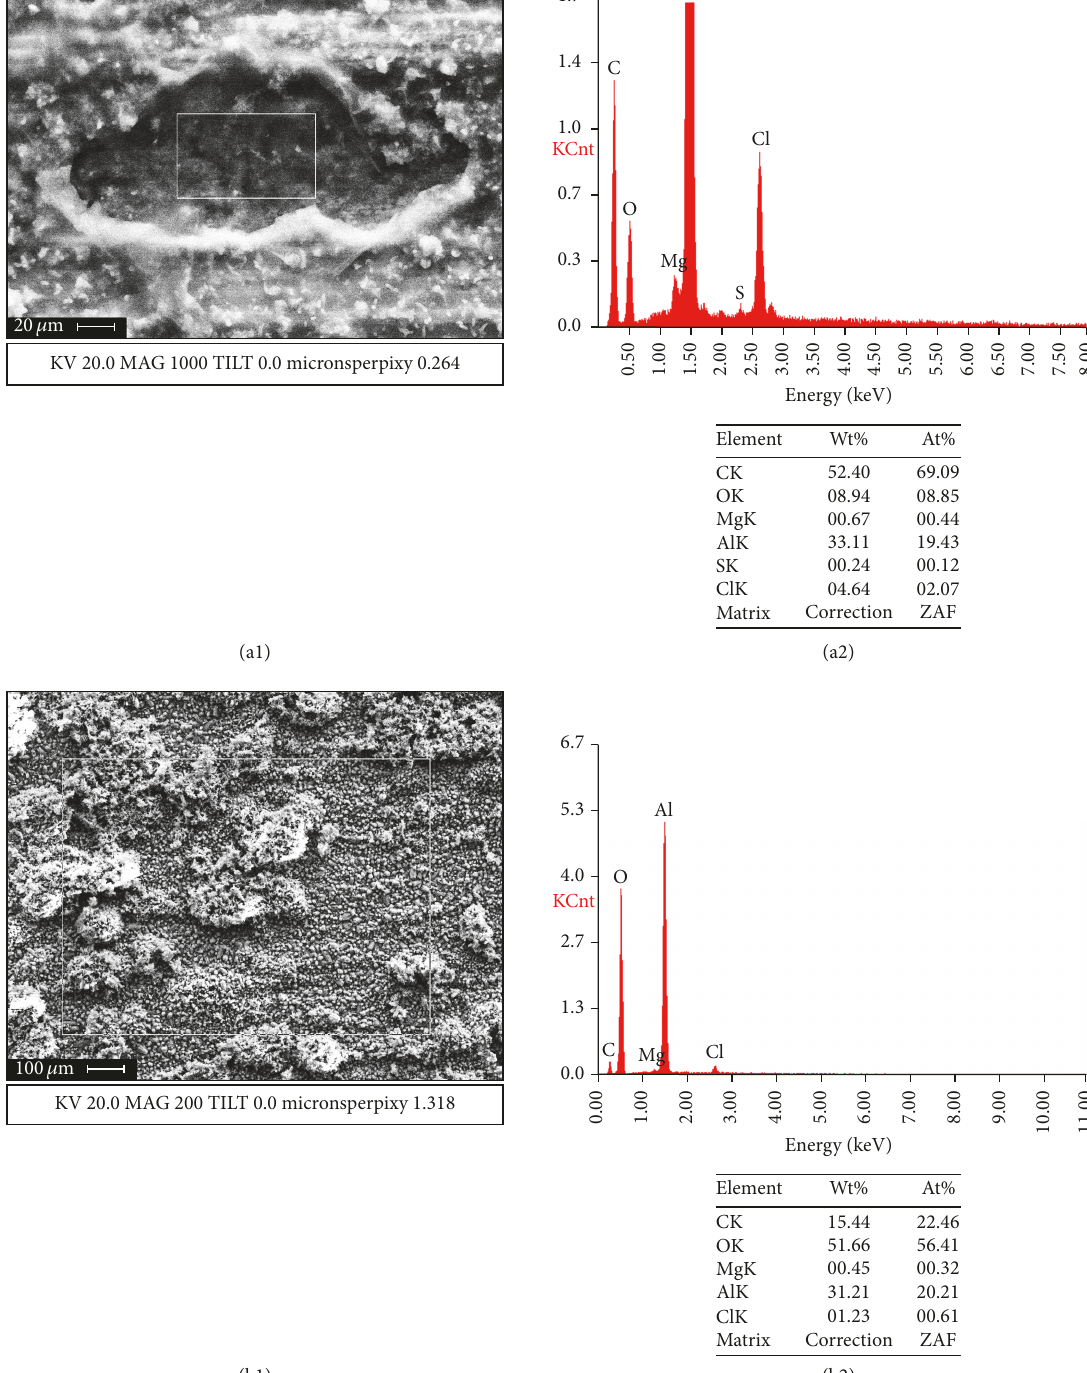
Figure 2: Analyzing the corrosion product of 2024-T31 aluminum-magnesium alloy immersed in different experimental systems for 30d.